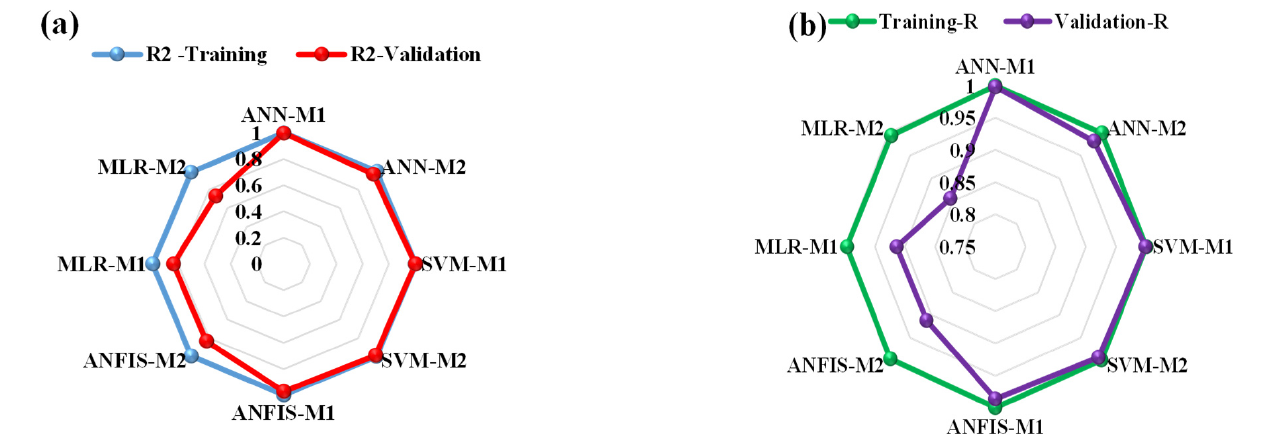
Figure 6. Time series plot for ANN-M2, ANFIS-M2, SVM-M2, and MLR-M2.